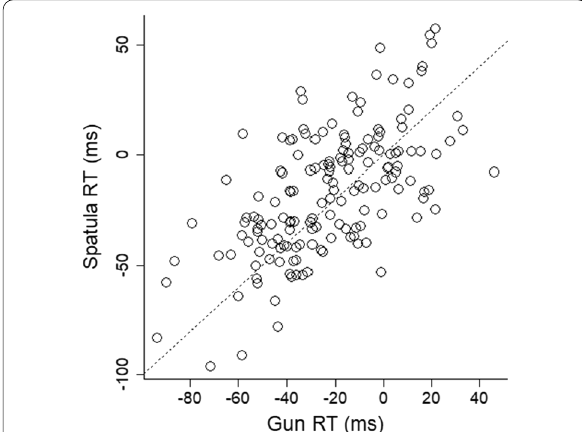
Fig. 6 RT difference scores when holding the spatula are plotted as a function of RT difference scores when holding the gun. Larger difference scores indicate increased time to respond when seeing a shoe relative to responding when seeing a gun. The line represents equality between the two conditions. The gun embodiment effect would be expressed as more points below the equality line, which would mean slower responses to seeing a shoe (vs a gun) in the hold gun condition compared with the hold spatula condition. These data were calculated using the 1.5xIQR criteria for outlier decisions (second to left column and bottom row in the multiverse)